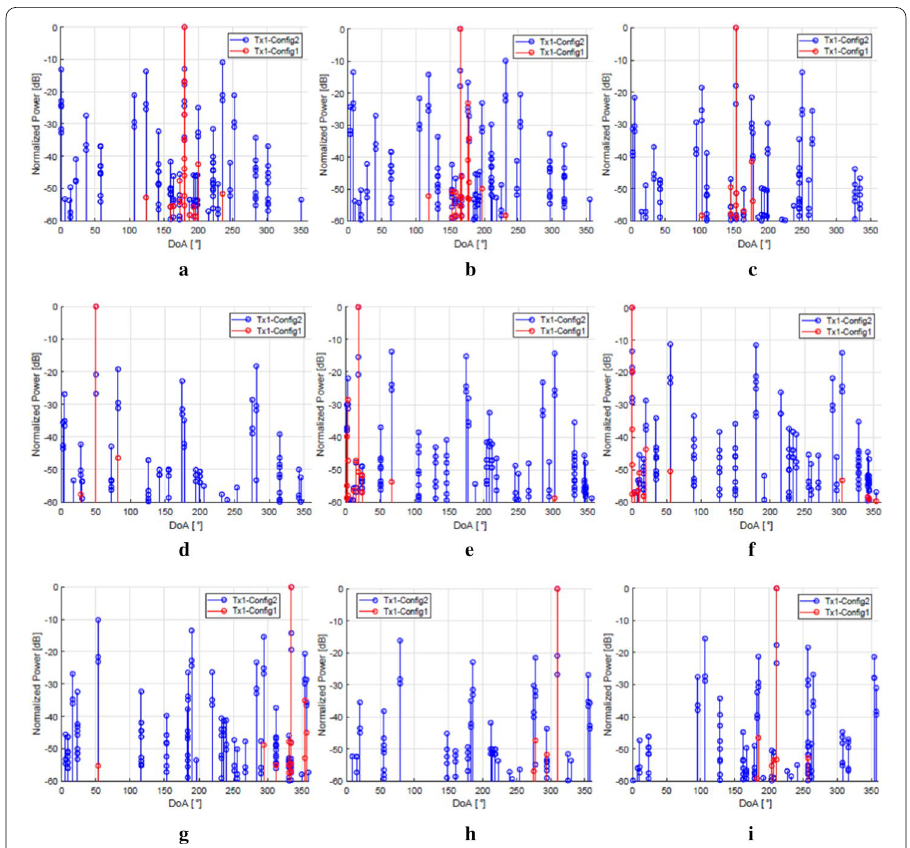
Fig. 16 Power angular profile. a Pos 1, b Pos 2, c Pos 3, d Pos 4, e Pos 5, f Pos 6, g Pos 7, h Pos 8, and i Pos